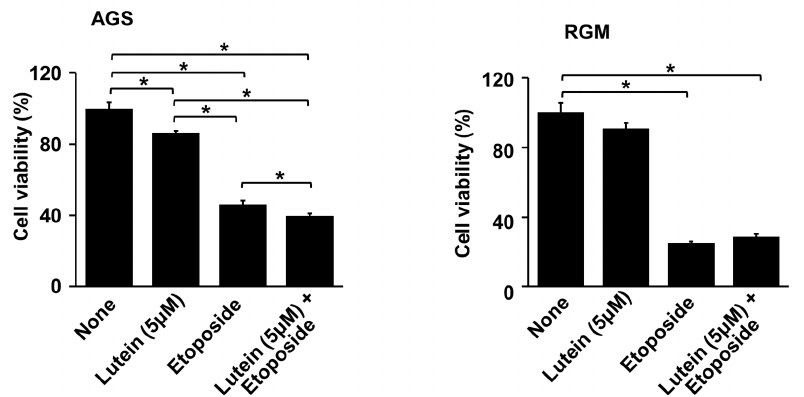
Figure 2. Effect of lutein on etoposide-induced cell death in AGS cells and RGM cells. The cells were pre-treated with 5 µ M lutein for 4 h and then treated with 10 µ M etoposide for 24 h. Cell viability was determined by counting the number of viable cells. The viability of untreated cells (“none”) was set at 100%. * p < 0.05. 2.3. Lutein Increases ROS Levels and NADPH Oxidase Activity in AGS Cells To determine the effect of lutein on ROS production, intracellular ROS levels were measured by DCFH-DA assay. Lutein (20 μ M) increased ROS levels at 1 h, and continued to do so until 3 h (Figure 3A, left panel). However, lutein did not increase ROS levels at 6 h or 12 h (Figure 3A, right panel). Lutein enhanced NADPH oxidase activity in AGS cells at 1 h, which decreased at 2 h (Figure 3B). These results show that lutein increased